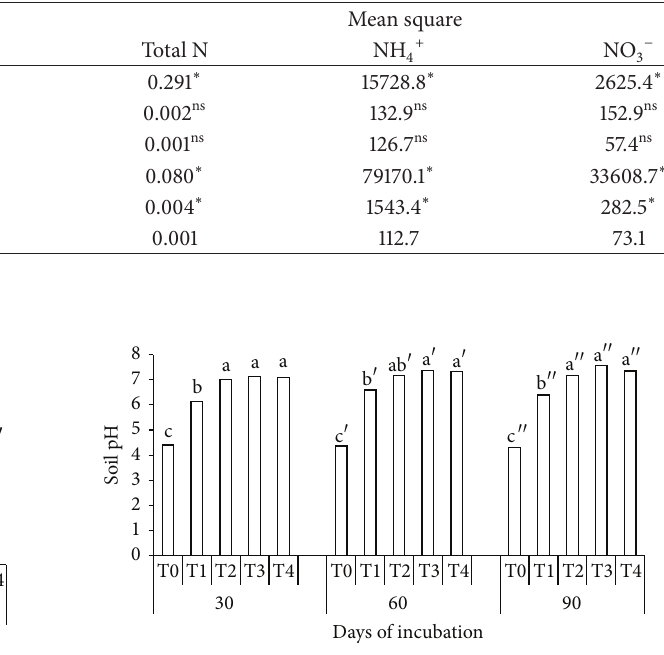
Figure 1: Effects of treatments (T0, T1, T2, T3, and T4) and periods (30,60,and90days)ofincubationonsoiltotalN. Note .T0:250gsoil (no urea); T1: 250 g soil + 7.40 g urea (no additives); T2: 250 g soil + 7.40 g urea + 6g clinoptilolite zeolite; T3: 250 g soil + 7.40 g urea + 6 g compost;T4:250 gsoil+7.40gurea+6 gcompost+6gclinoptilolite zeolite. Means with the same letter are not significantly different by Tukey’s test at 𝑃 ≤ 0.05 . Note . Letters without prime represent 30 DAI, single prime superscript represents 60 DAI, and double prime superscript represents 90 DAI.